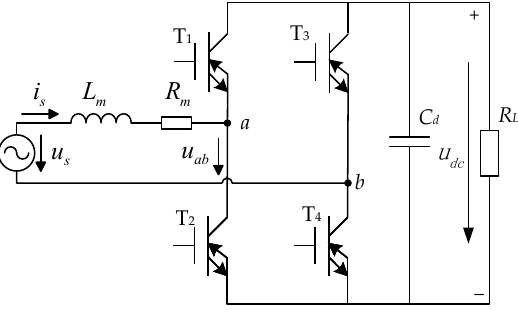
Figure 5. Main circuit structure of single-phase voltage-source pulse width modulation (PWM) converter with RC-IGBT.